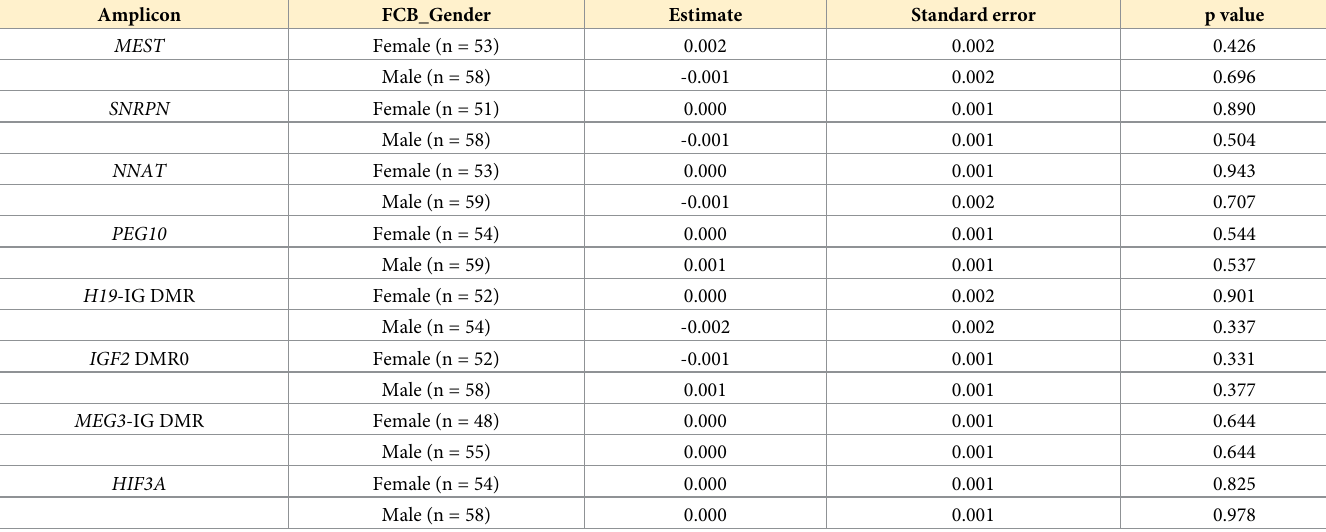
Table 4. Multivariable regression analysis using linear models: Fetal cord blood DNA methylation in relation to maternal body mass index.